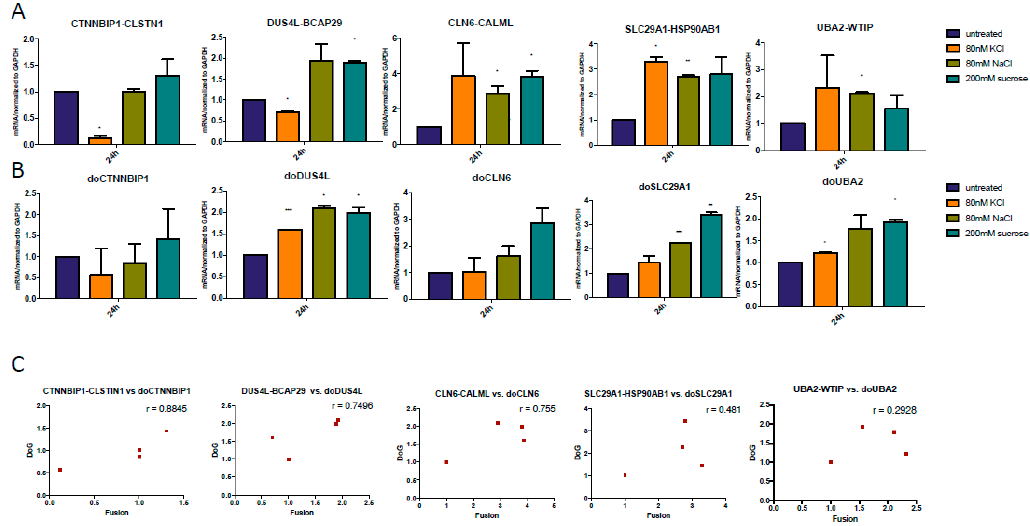
Figure 5. Positive correlation between DoGs and corresponding Cis-SAGe RNAs at 24 h after osmostress. ( A ) cis-SAGe fusion RNAs were measured. Most of them were induced by osmostress; ( B ) DoGs of the 5’ parental genes of the fusions were measured. Most of them were also induced by osmostress. The levels of various transcripts were normalized to that of GAPDH and further normalized to the untreated samples; ( C ) The levels of the DoGs and their fusion RNAs were plotted in scatter plots. *: p < 0.05, **: p < 0.01, ***: p < 0.001.